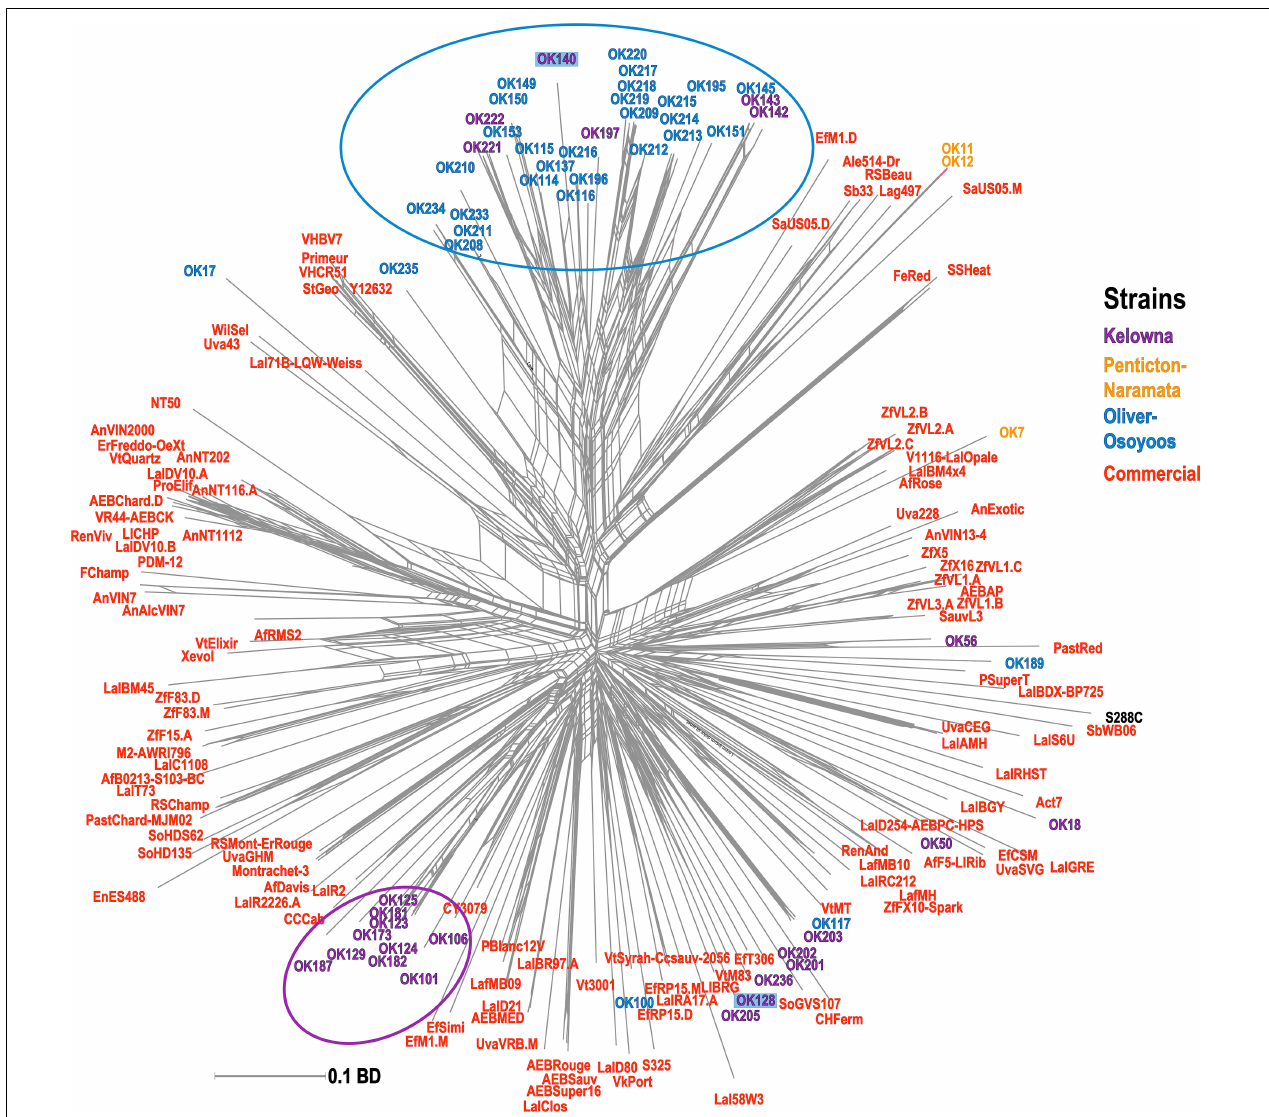
FIGURE 4 | Phylogenetic network of unknown and commercial S. cerevisiae MLGs. The phylogenetic network was built with the Neighbor-Net algorithm using a pairwise BD matrix. Unknown strains are labeled as OK and are colored by sub-region of origin; strains isolated from multiple sub-regions are highlighted. Commercial MLGs from the commercial strain collection are in red; the S. cerevisiae reference lab strain S288C is in black. Distinct sub-regional clusters of strains are